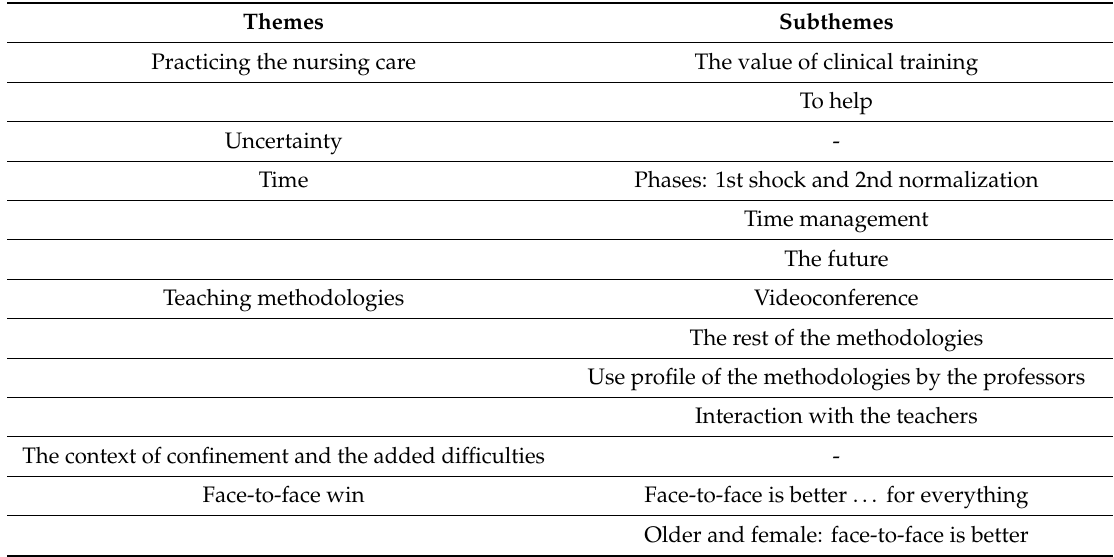
Table 2. Themes and